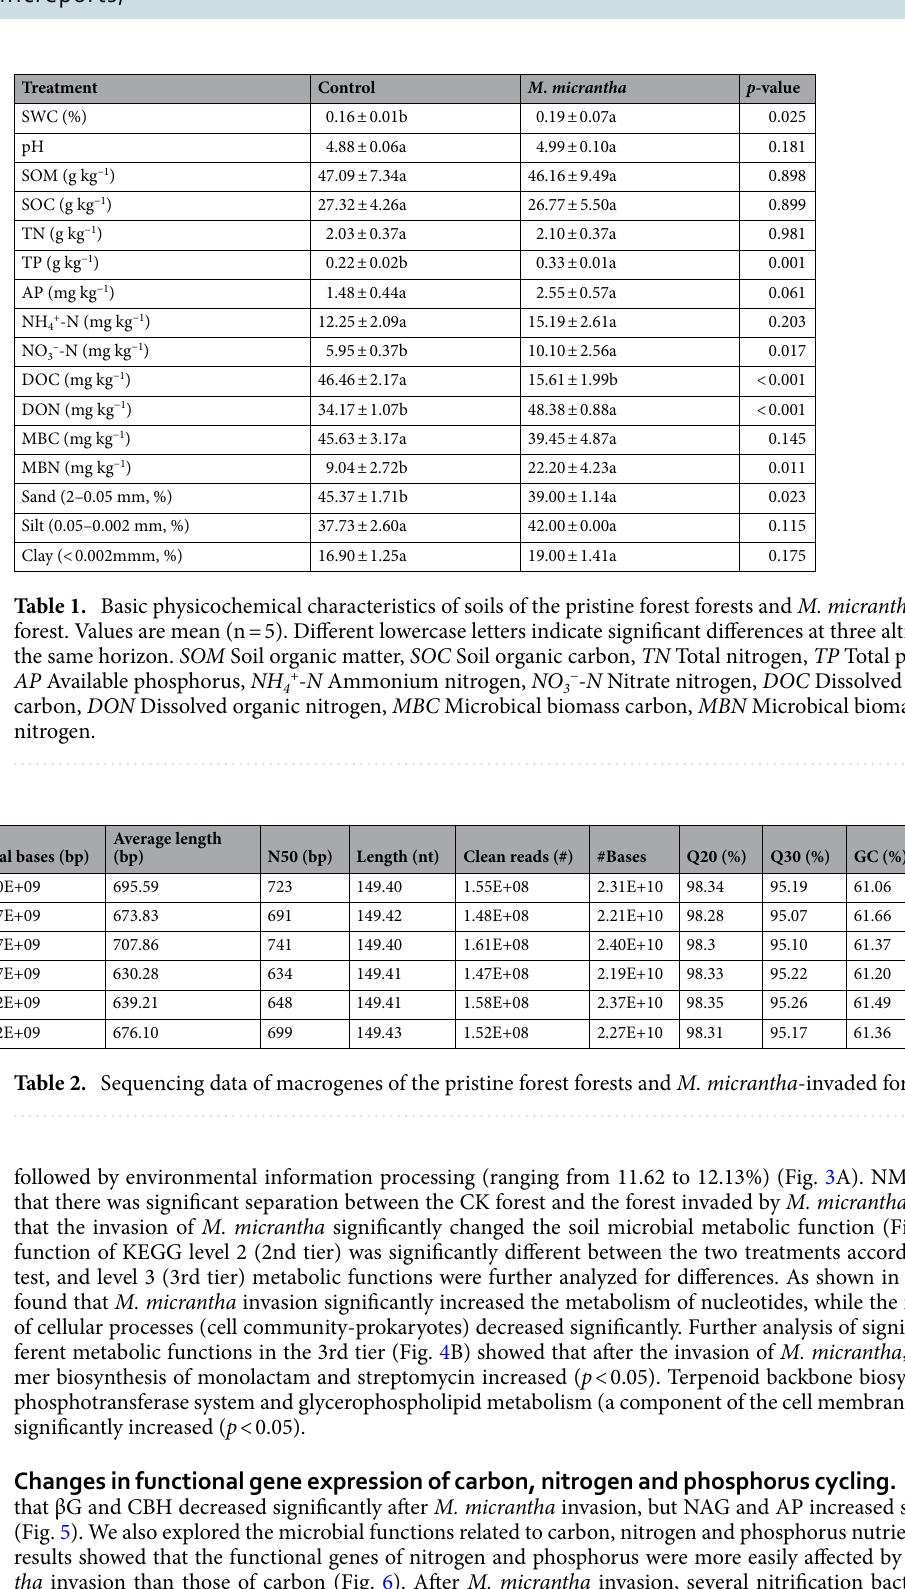
pentose phosphate pathway increased after M. micrantha invasion, while other carbon metabolism pathways did not change significantly (Fig. 6D).